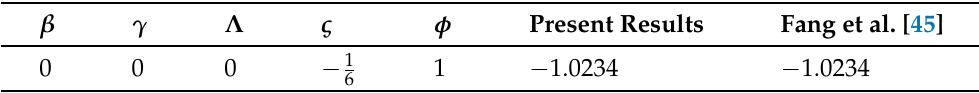
Table 6. Numerical comparison between present results with previously report results [45] for skin friction profile.